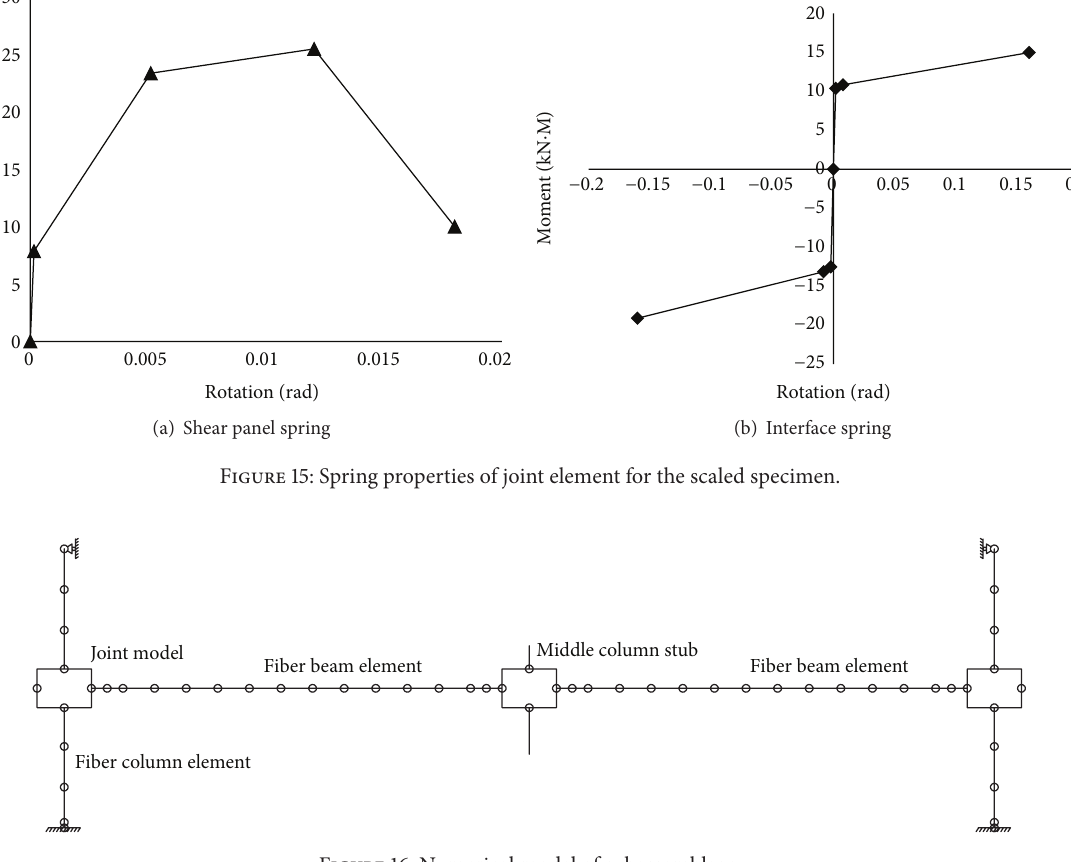
Figure 16: Numerical model of